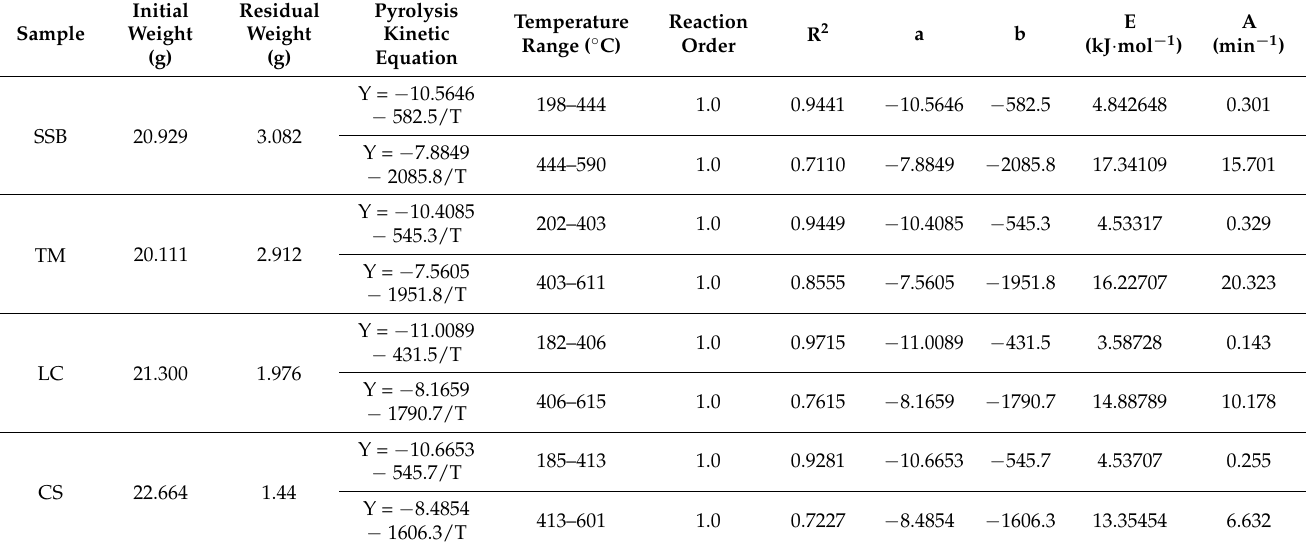
Table 2. Results of pyrolysis kinetics of